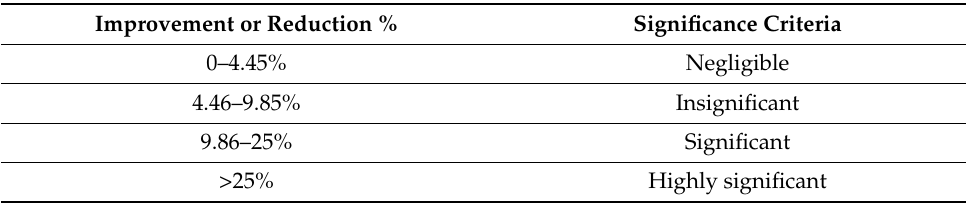
Table 6. The significance criteria for various properties of